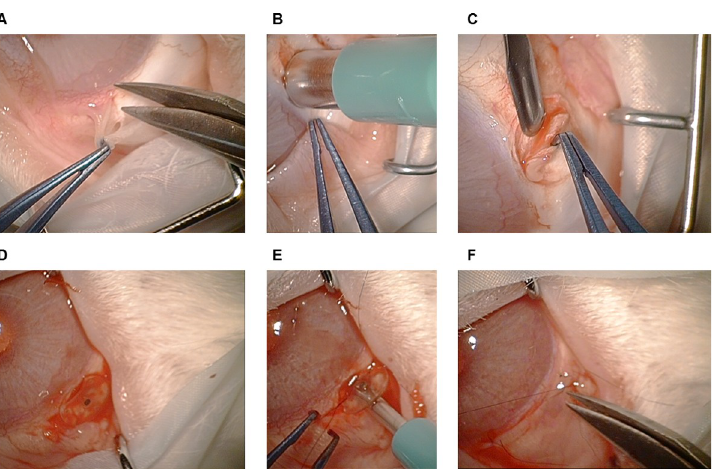
Fig 2. Implantation. (A) Preparation of the fornix-based conjunctival flap in the superior temporal bulbar quadrant. (B) The scleral bed is prepared with a 4 mm biopsy punch. (C) The superficial scleral flap is resected. (D) The implant is positioned in the prepared scleral bed before being provisionally fixed. (E) The sclerectomy is performed with a 1 mm biopsy punch. (F) The conjunctival flap is repositioned and fixed. Anaesthesia was antagonised by an atipamezole hydrochloride injection (0.15 mg/kg). A subcutaneous depot of 60 mL full electrolyte solution was also administered